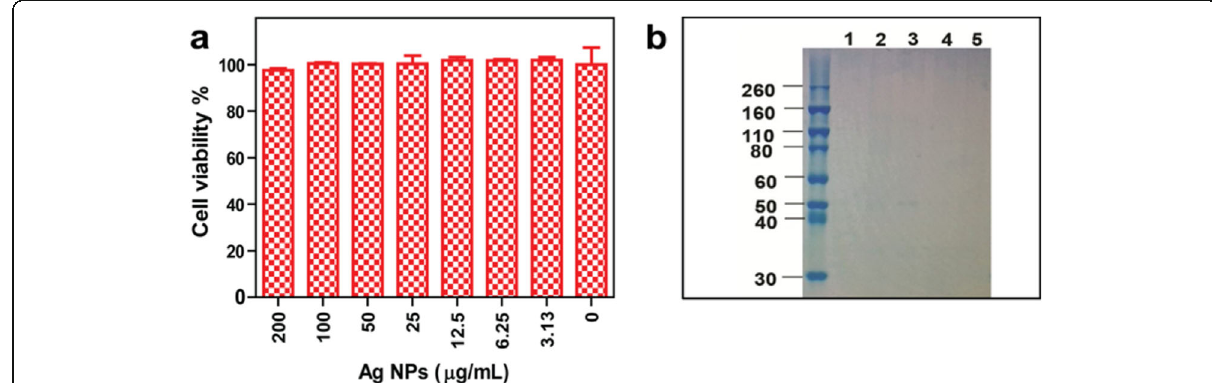
Fig. 5 a Cytotoxicity of Ag NPs in Cos-7 cells and, b SDS-PAGE analysis. Lane 1: loading buffer control. Lanes 2 – 4: synthesized Ag NPs. Lane 5: yeast extract centrifuged with 8000